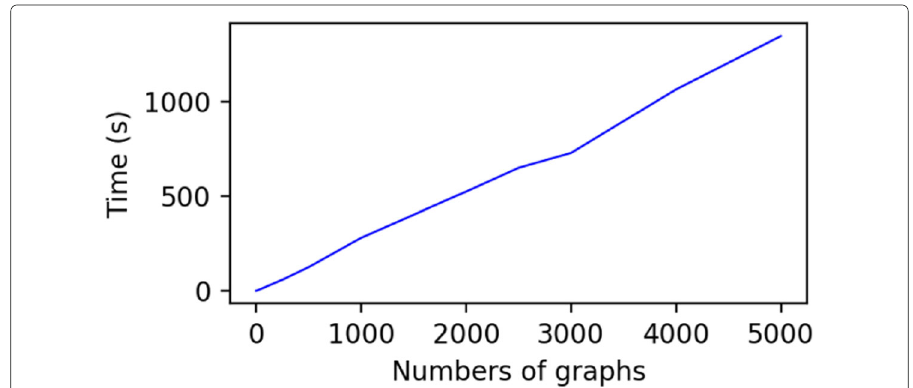
Fig. 14 Growth of training time versus number of